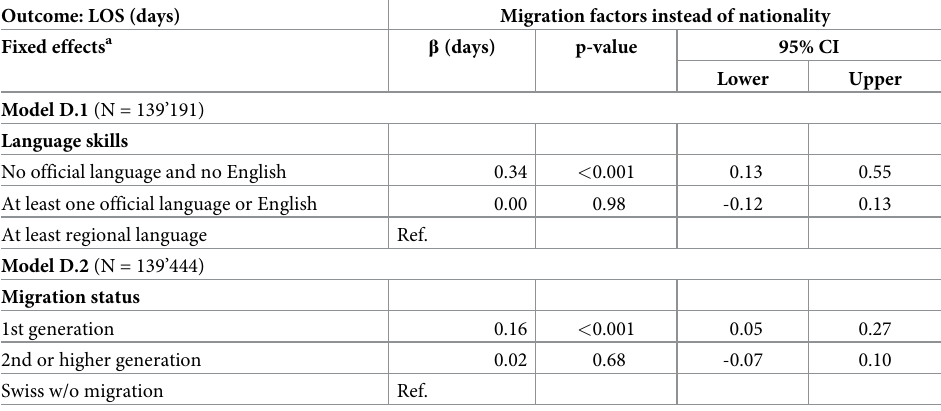
Non-Swiss nationals stayed about 0.2 days longer in hospital compared to Swiss nationals (Model D) while allophone patients stayed about 0.34 days longer in hospital compared to those who spoke the local language (p = 0.002, Model D.1) (Table 5). Interaction tests in Table 5. Associations of length of stay with migration factors (linear CCMM D.1 and